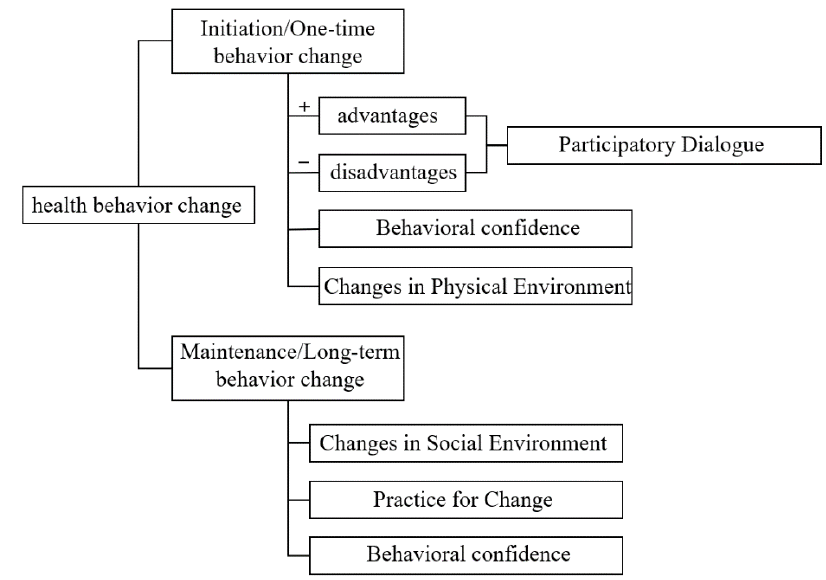
Figure 1. The framework of MTM.